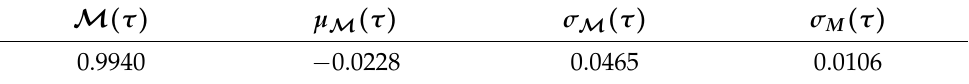
Figure 2. Expected (9) and Random Components of the SDF (10). Table 2. Mean and Standard Deviation for Expected and Random Components of the